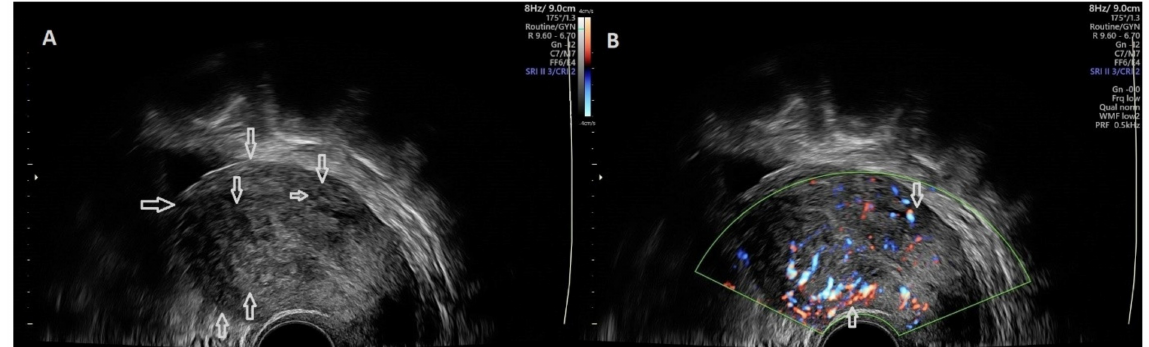
Figure 1. ( A ) B–mode, TVUS characteristics of uterine adenomyosis (featured in the superior part of the image) and a uterine fibroid (inferior part of the image) (pointed out through the arrows): globally increased uterine volume with myometrial cysts and ill-defined lesion; round lesion, with clear, distinct borders and fan-shaped shadowing. ( B ) B–mode TVUS with Power Doppler mode features of uterine adenomyosis (superior part of the image) and uterine fibroid (inferior part of the image) (highlighted by the arrows): trans–lesional blood flow; circumferential blood